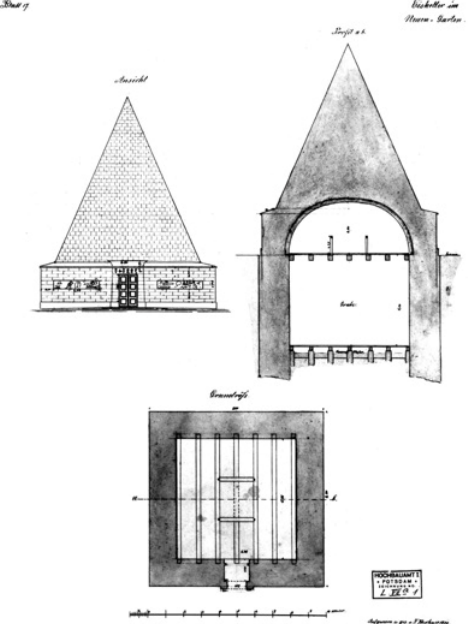
Figure 3. The ice pyramid in Neuen Garten in Potsdam. Accd. to Gussone 2008.